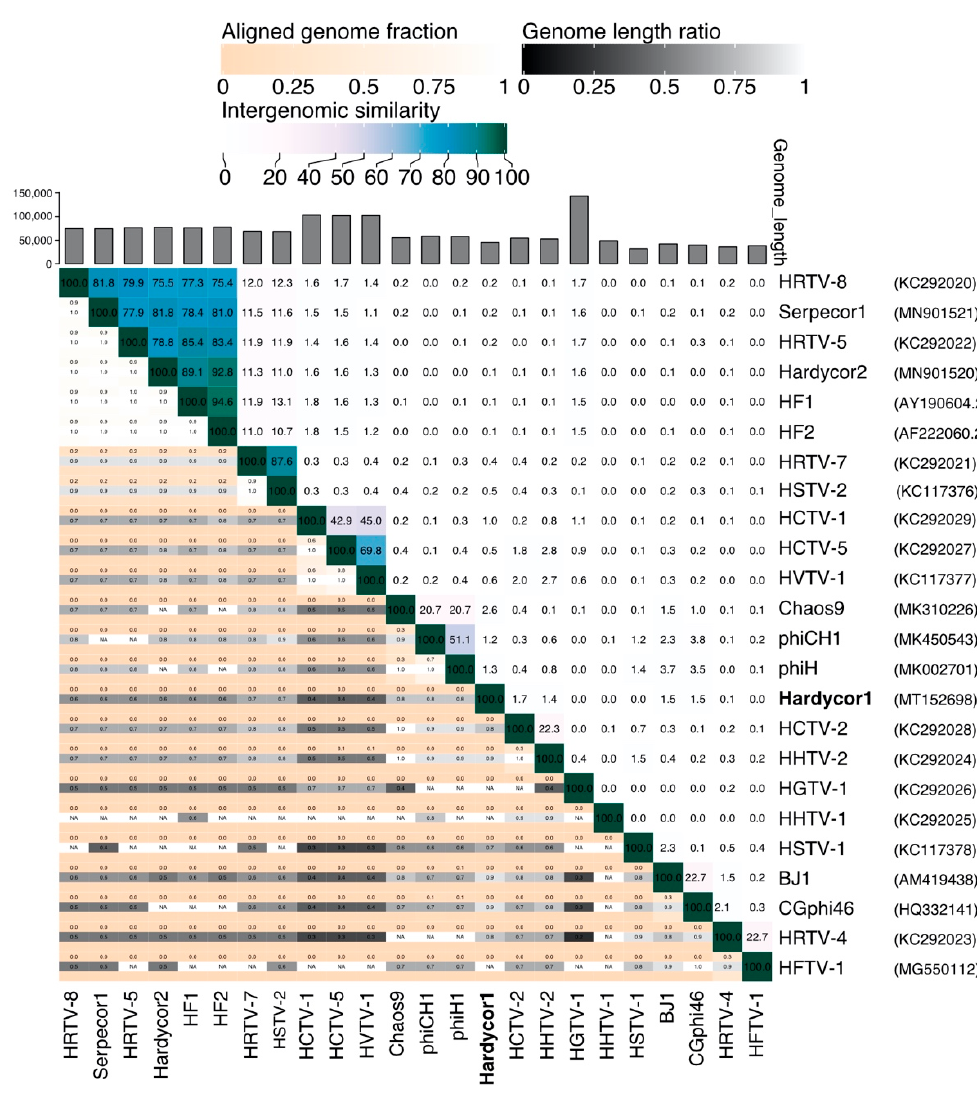
Figure 3. Intergenomic similarity of haloviruses (upper right triangle) based on whole genome sequences and calculated using the VIRIDIC webserver. Both colour scale (top) and numeric values are displayed. Lower left triangle displays aligned genome fraction and genome length ratio (colour scales shown at top). Genome lengths are indicated by vertical bars at top edge. Virus names and GenBank accessions are shown at right